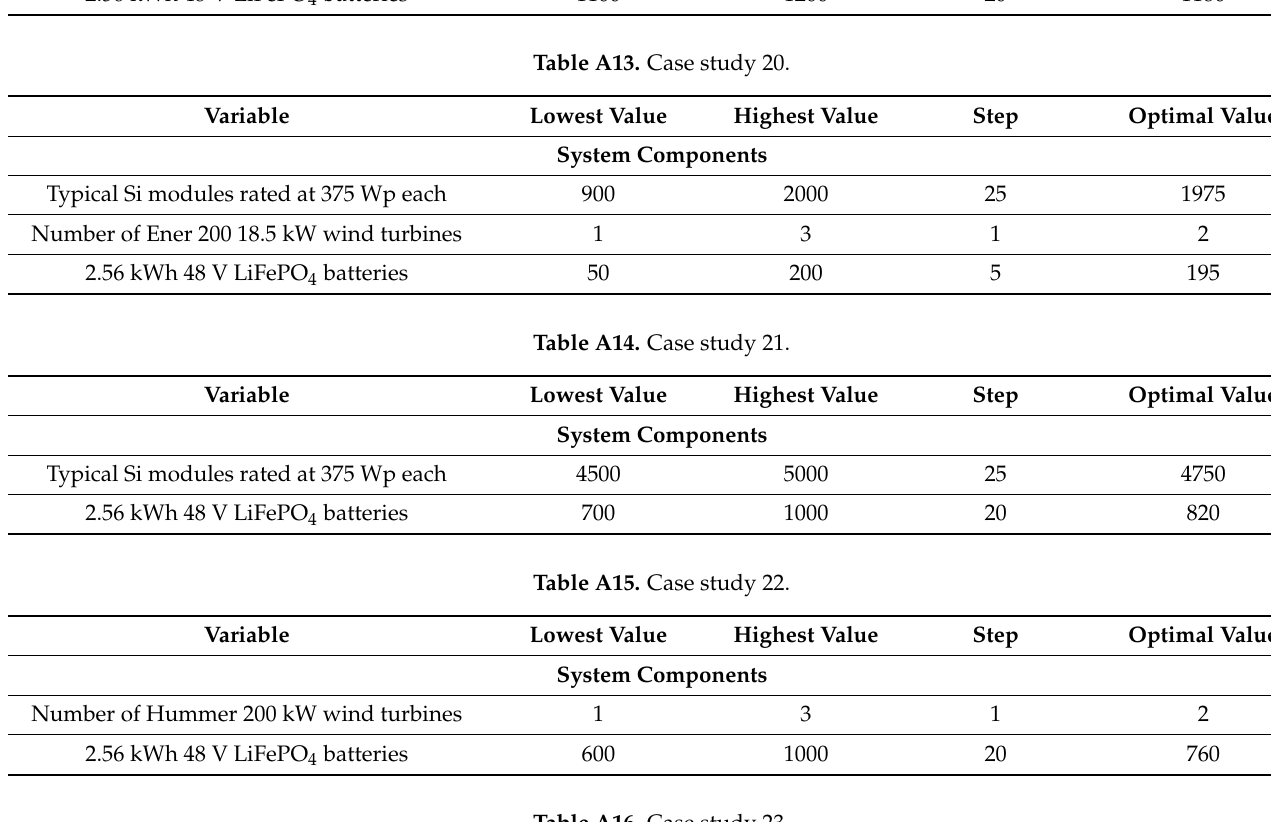
Table A16. Case study